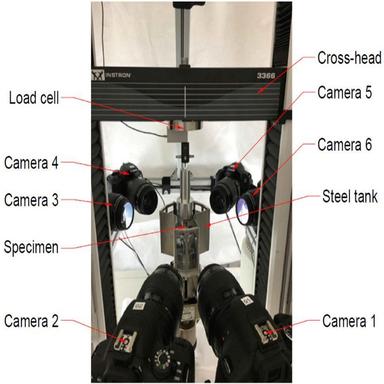
The digital image correlation (DIC) setup for testing an anterior cruciate ligament. (a) Schematic view of the DIC setup around the tensile testing machine. (b) Complete built of the DIC setup showing all six cameras, stainless-steel tank and the specimen submerged in 20 ml buffer solution (15 ml of 20 mM Tris pH 7.5, 150 mM NaCl, 5 mM CaCl2) with protease inhibitors (1 tablet of mini-cOmplete per 10 ml of buffer, SIGMA-ALDRICH/Roche, USA).